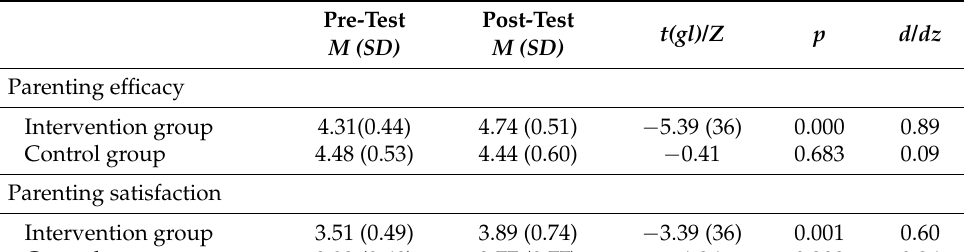
Figure 2. Parenting efficacy in intervention and control groups on pre-test and post-test. Table 2. Pre-test and post-test comparison of parental competences in the intervention ( N = 42) and control ( N = 24) groups.